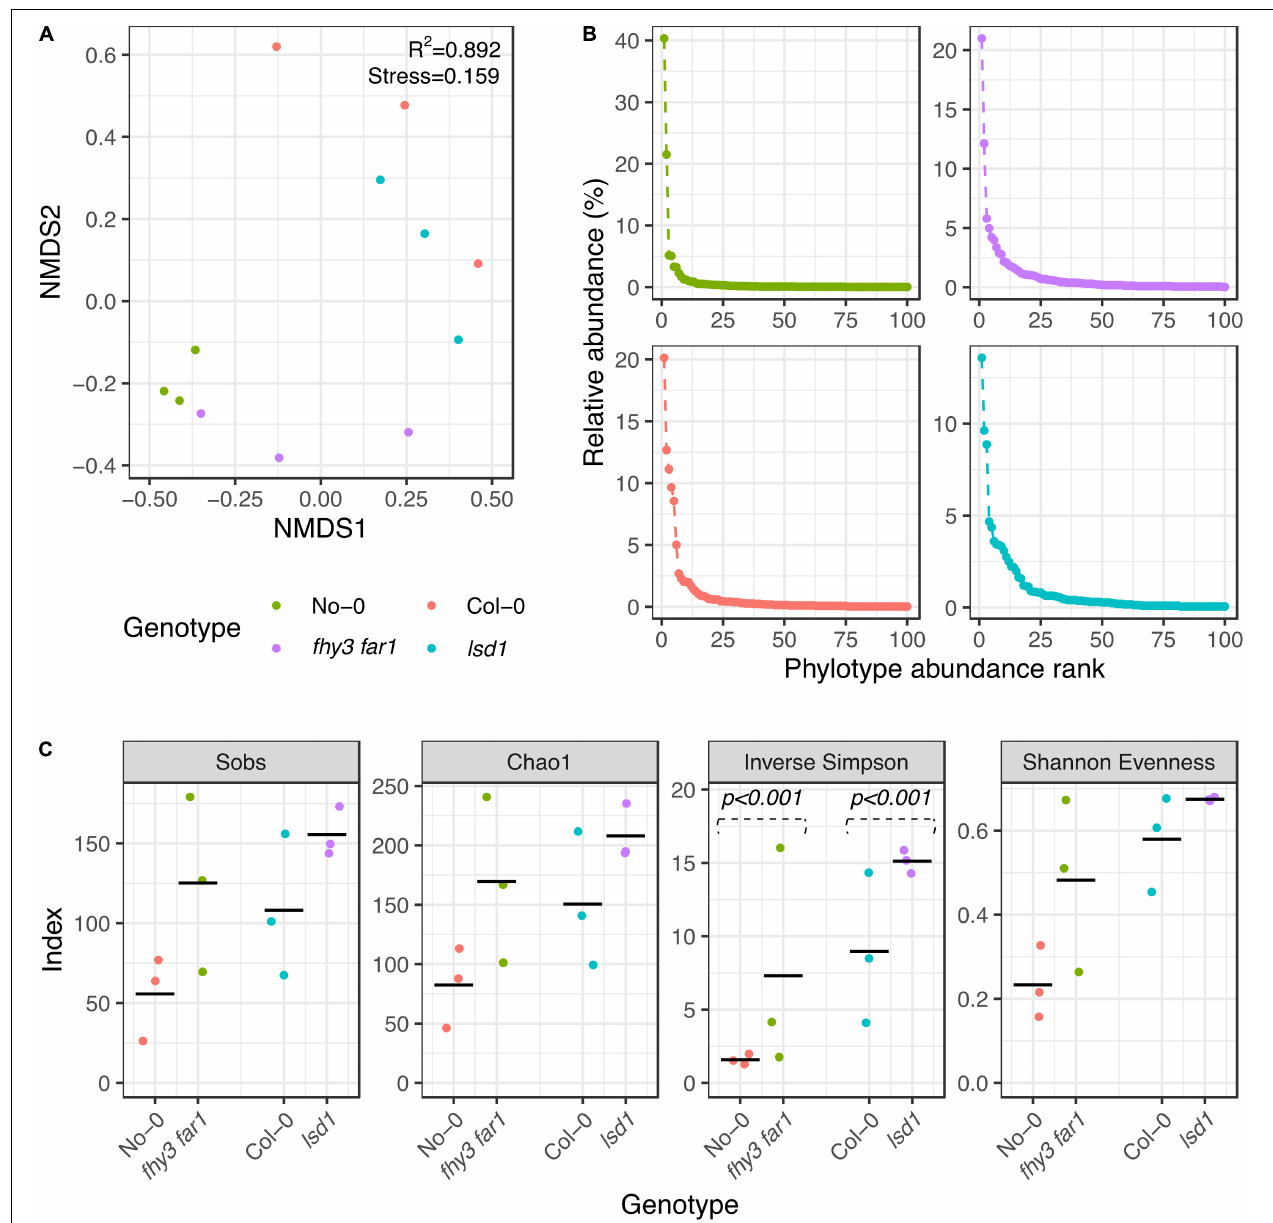
FIGURE 1 | Alpha and beta diversities of phyllospheric bacterial communities in wild type and salicylic acid signaling mutants. (A) Non-metric multidimensional scaling of Bray-Curtis dissimilarities (Bray and Curtis, 1957) of phyllospheric bacterial communities across all four genotypes. Analysis carried out using 10 iterations with ε = 1e-12. (B) Ranked abundances of 100 most abundant phylotypes. (C) Alpha diversity estimations of bacterial phyllospheric communities. The Sobs calculator shows the number of phylotypes identified; the Chao1 estimator shows the estimated species richness (Chao, 1984); and the inverse Simpson and Shannon evenness index show the community diversity and richness, respectively (Shannon, 1948; Simpson, 1949). Statistical comparison of Simpson diversity index values was carried using the Past4 Diversity t- test function (Hutcheson, 1970) on averaged phylotype counts for each genotype. All other analyses and initial index values were calculated using mothur (v.1.44.3) (Schloss et al., 2009) from bacterial 16S rRNA sequences present in the phyllosphere microbiomes of four A. thaliana genotypes ( n = 3 for all genotypes) 35 DAS. Samples were subsampled down to the size of the sample with the lowest number of sequences before